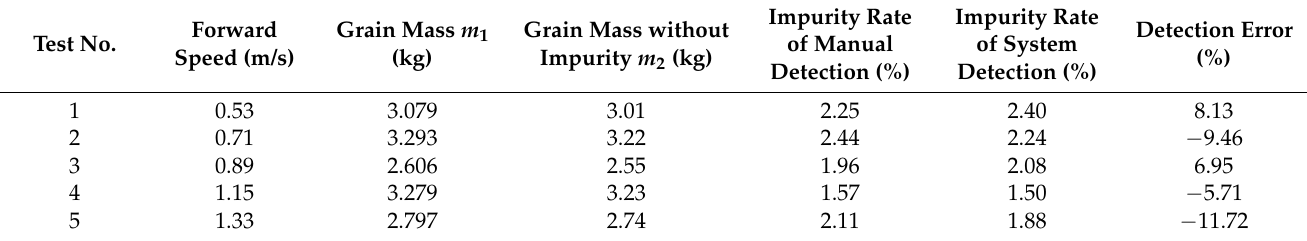
Table 6. Field test